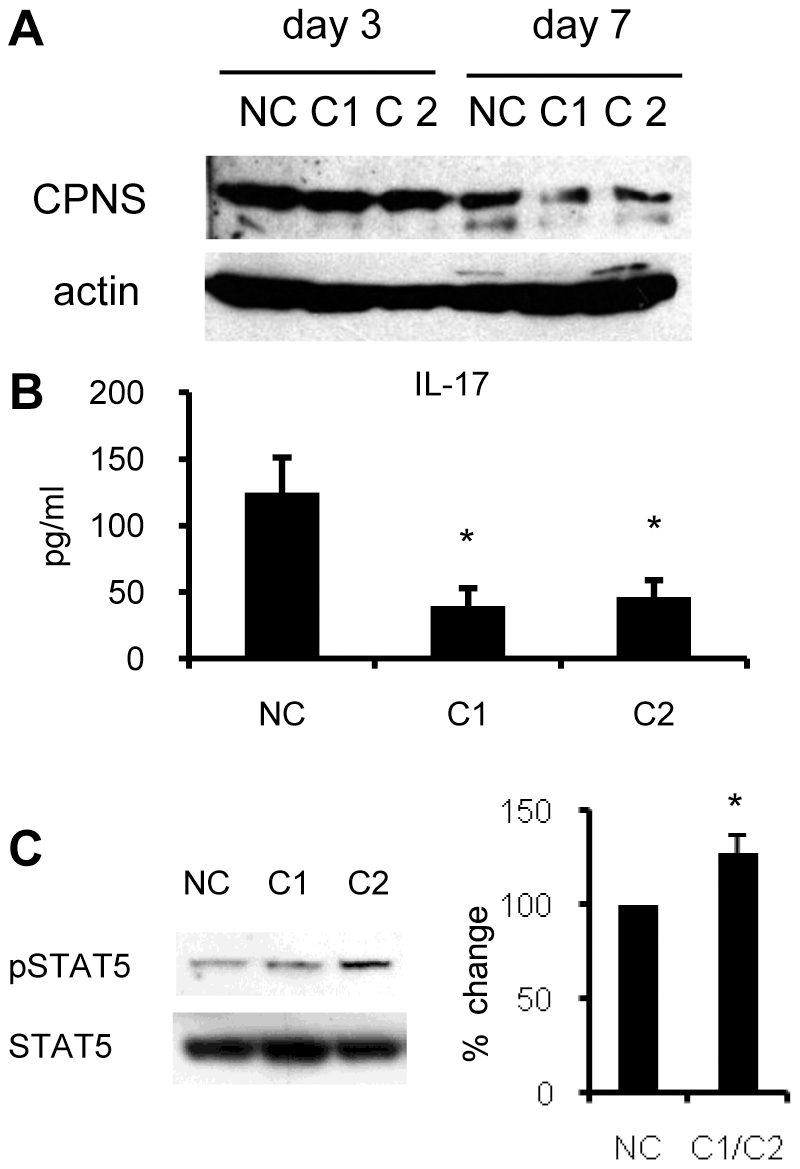
Silencing of the calpain small subunit suppressed the IL-17 production from Th cells.(A) Naïve CD4+ T cells were cultured under neutral conditions, and treated with siRNA against calpain small subunit (CPNS). This experiment was carried out using two siRNAs (CPNS1; C1 and CPNS2; C2). On day 3 and 7, these cells were lysed and subjected to western blot analysis. NC; negative control. (B) On day 6, the cells in panel A were washed 3 times and restimulated with an anti-CD3 antibody for 48 hours. The culture supernatants were then collected, and IL-17 was measured by ELISA. Statistical analysis of eight independent experiments is shown (Steel's test). (C) On day 6, the cells in panel A were incubated with X-VIVO™ 20 (without FCS) for the last 6 hours, then lysed and subjected to western blot analysis with the indicated antibodies. Similar results were obtained in three independent experiments. The band densities of pSTAT5 were measured and normalized to that of total STAT5, then the percent change from NC was calculated. Statistical analysis of three independent experiments is shown in the right panel. *p<0.05 vs. NC.